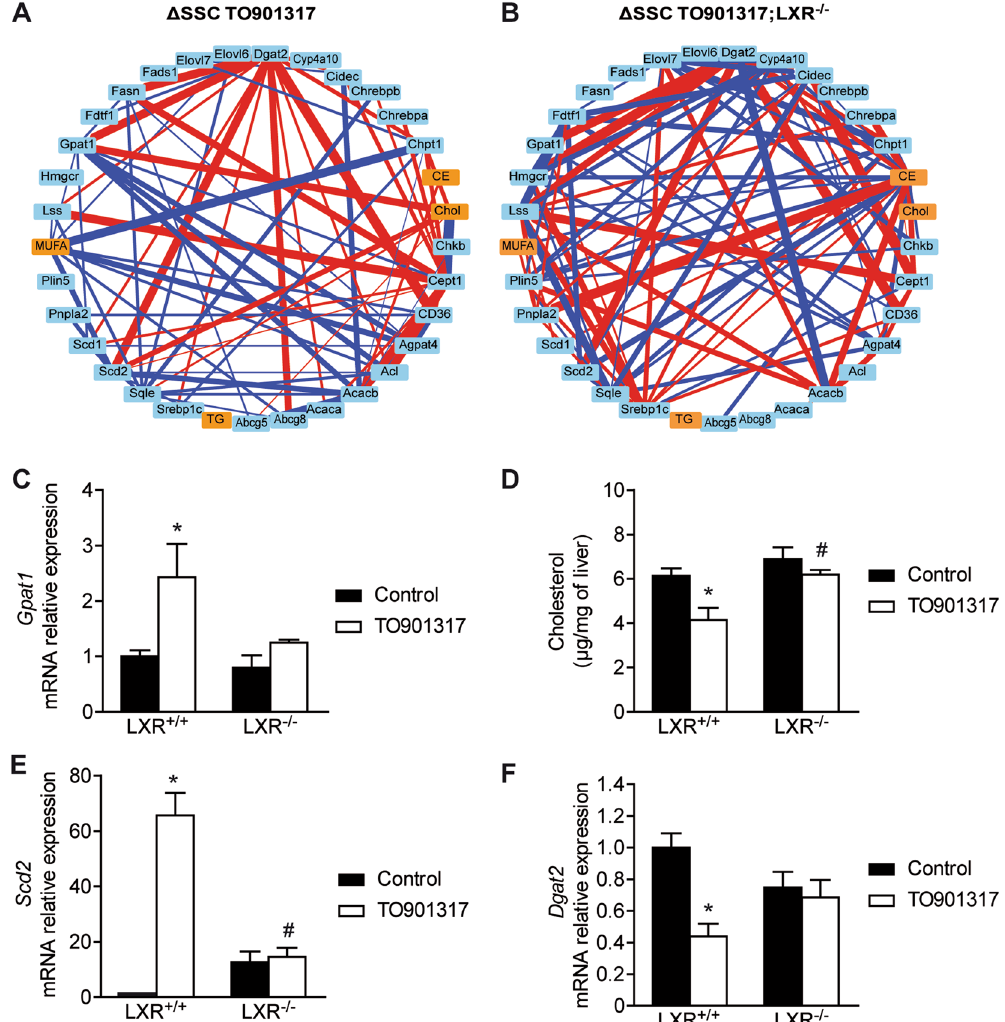
Figure 6. Single-sample network (SSN)-based analyses revealed a potential link between genes. LXR regulation and lipid homeostasis in mice treated with TO901317. ( A , B ) SSN-based analysis of the expression of 74 mRNAs (pale blue square) and 4 types of lipids (orange square). CE: cholesterol ester, Chol: cholesterol, MUFA: mono-unsaturated fatty acid, TG: triglyceride. Blue lines represent a gain of correlation, whereas red lines represent a loss of correlation, with a width proportional to the difference in correlation. Only edges of △ SSC with P < 0.05 are presented. ( C ) Gpat1 quantification assayed by qPCR. ( D ) Liver cholesterol was analyzed by gas chromatography. ( E , F ) Scd2 and Dgat2 mRNA quantification assayed by qPCR. Data are presented as means ± s.e.m. LXR + / + and LXR − / − mice were treated with vehicle or T0901317 (n = 5 mice per group). * P < 0.05 for the effect of T0901317 on the same genotype. § P < 0.05 for the effect of LXR knock-out on the same